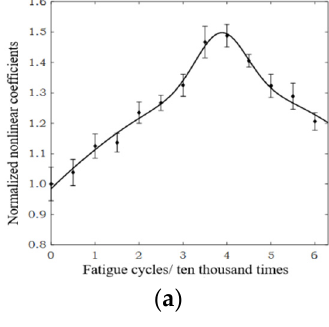
Figure 7. The normalized ultrasonic nonlinear coefficients vary with the fatigue cycles. ( a ) Specimen B1. ( b ) Specimen B2. ( c ) Specimen B3.